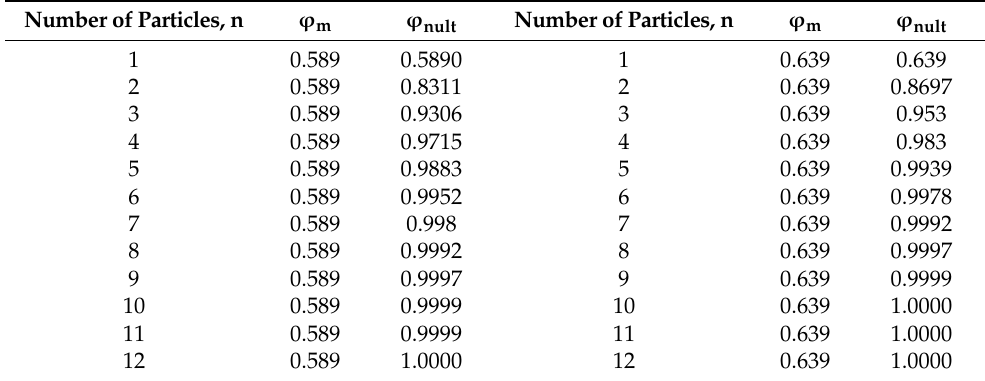
Table 2. Theoretical ultimate packing fraction based on the number of particles for both loose and dense mono-disperse packing